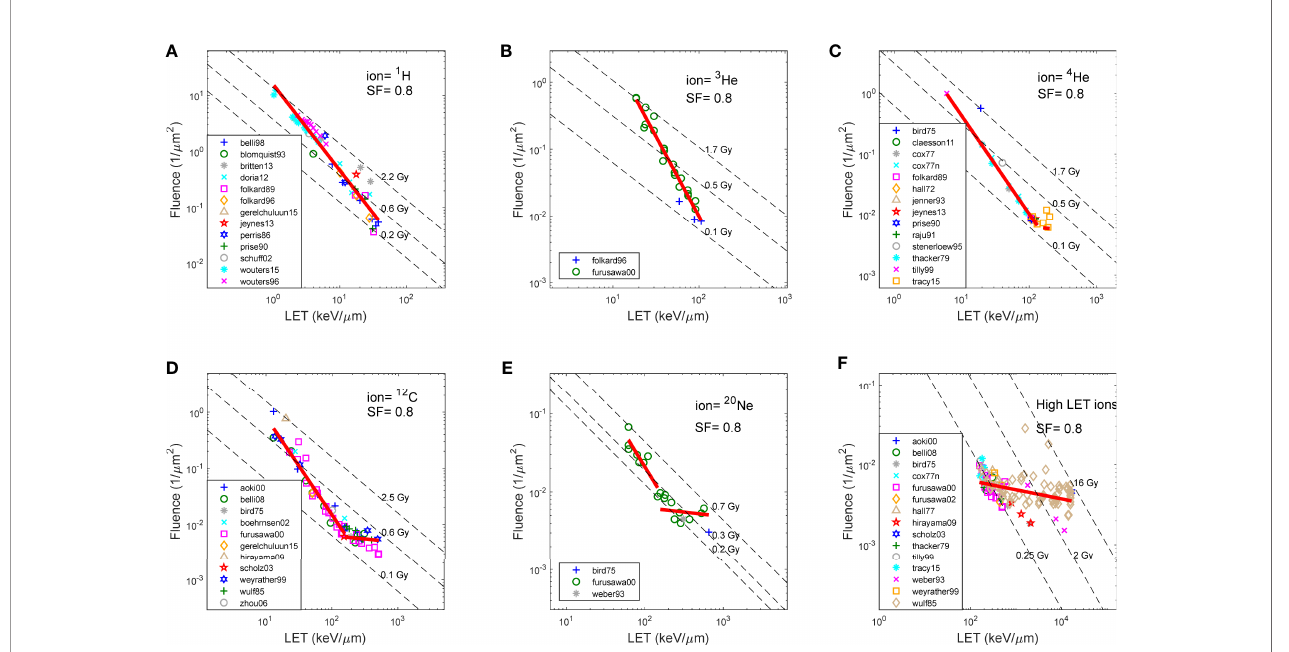
FIGURE 2 | Fluence and LET required to achieve SF of 0.8, for V79 cells in asynchronized cell cycle using various ions, as reported in literature. (A) 1H (proton), (B) 3He, (C) 4He, (D) 12C, (E) 20Ne, and (F) High LET ions (>150 keV/ m m). Note that the same fi tting in (F) was applied to high LET region of the plots in (C-E)